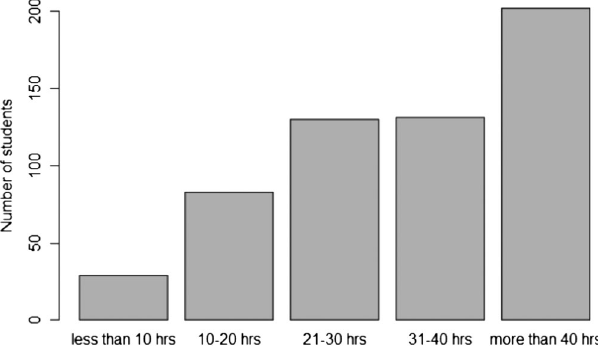
FIG. 1. Time per week spent studying.